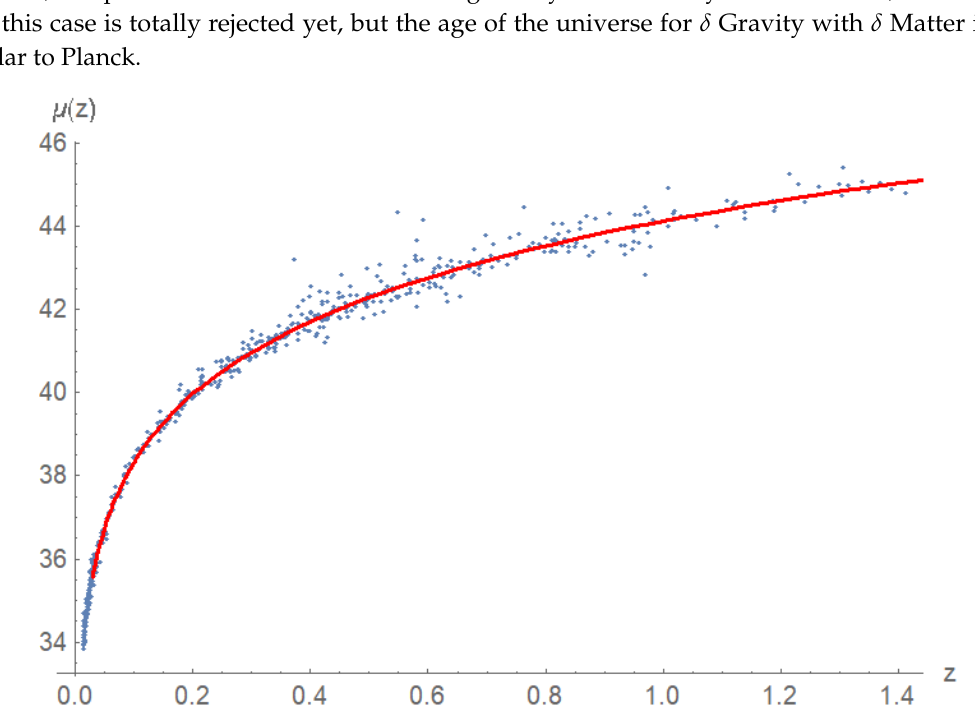
Figure 1. Distance modulus vs. Redshift. We have fitted 580 supernovae to δ Gravity, using the parameters that minimize Equation